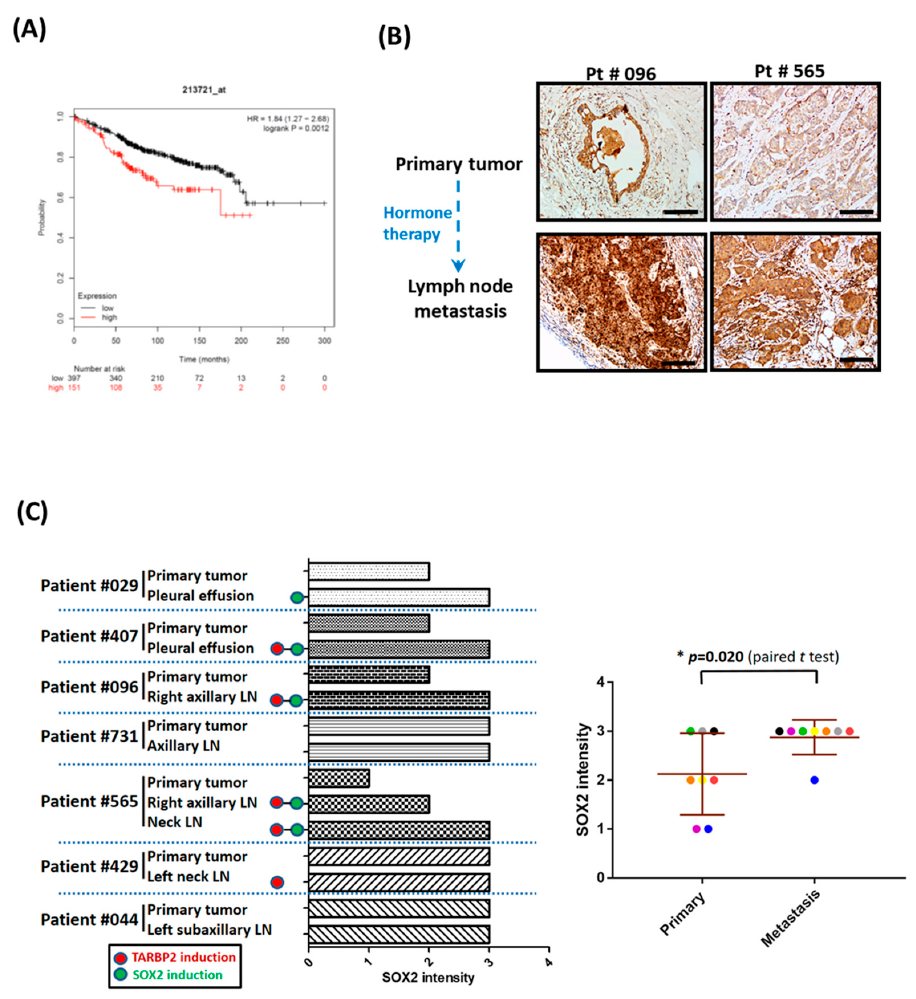
Figure 7. Figure 7 . Cont.